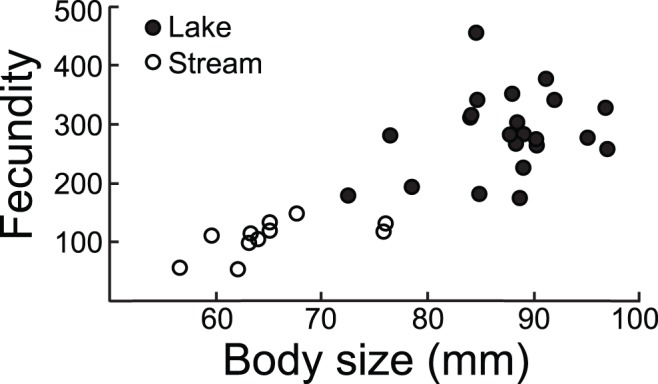
Fecundity in relation to body size in female stickleback from Lake Constance and its tributary streams.Fecundity is expressed as number of eggs per clutch. Within each habitat class, samples were pooled across different locations (lake: N = 22; stream: N = 11).